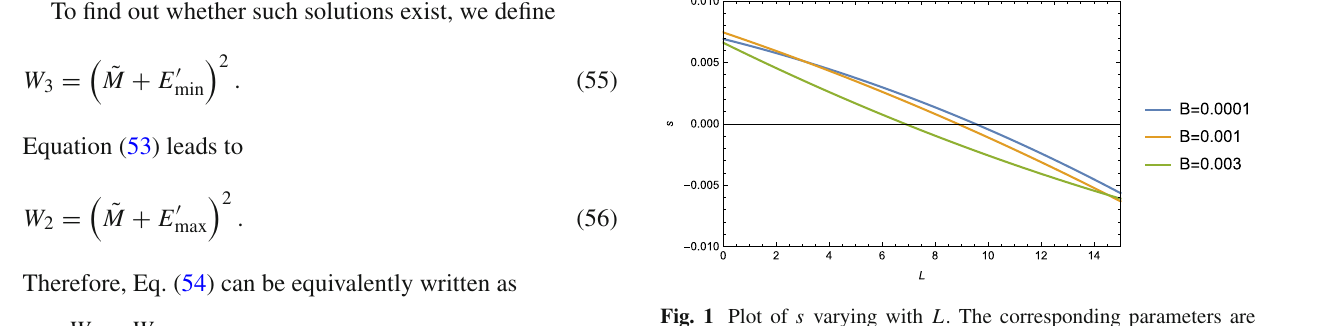
Fig. 1 Plot of s varying with L . The corresponding parameters are M = 100, a = 80, Q = 60, q = 0 . 1, and B = { 0 . 0001 , 0 . 001 , 0 . 003 } . When L is small, s is positive, meaning that the horizon could be